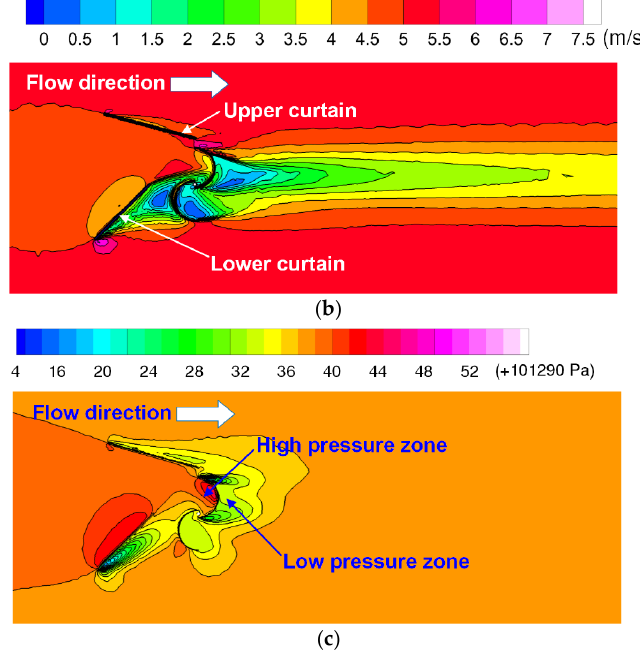
Figure 2. Cross-sectional flow parameter distributions with upstream curtains. ( a ) Configuration of upper and lower curtains [26]; ( b ) Velocity distribution; ( c ) Static pressure distribution.